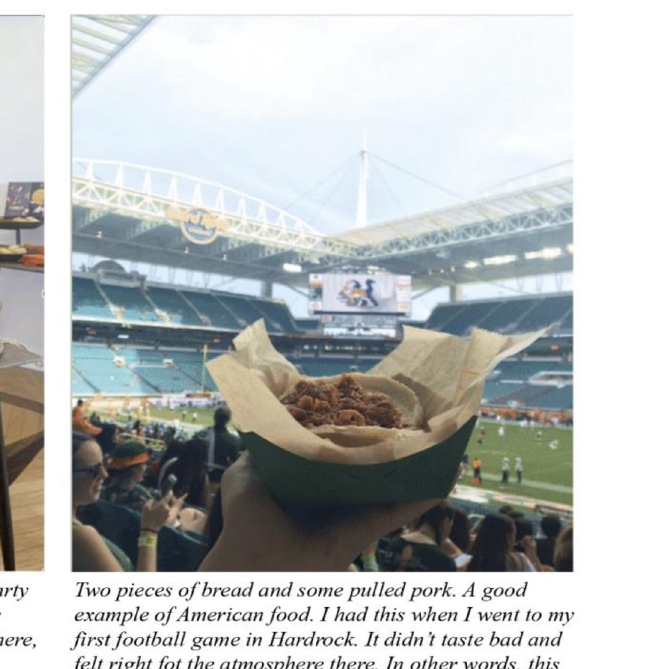
FIGURE 3 | Healthy food consumption as a symbol cultural